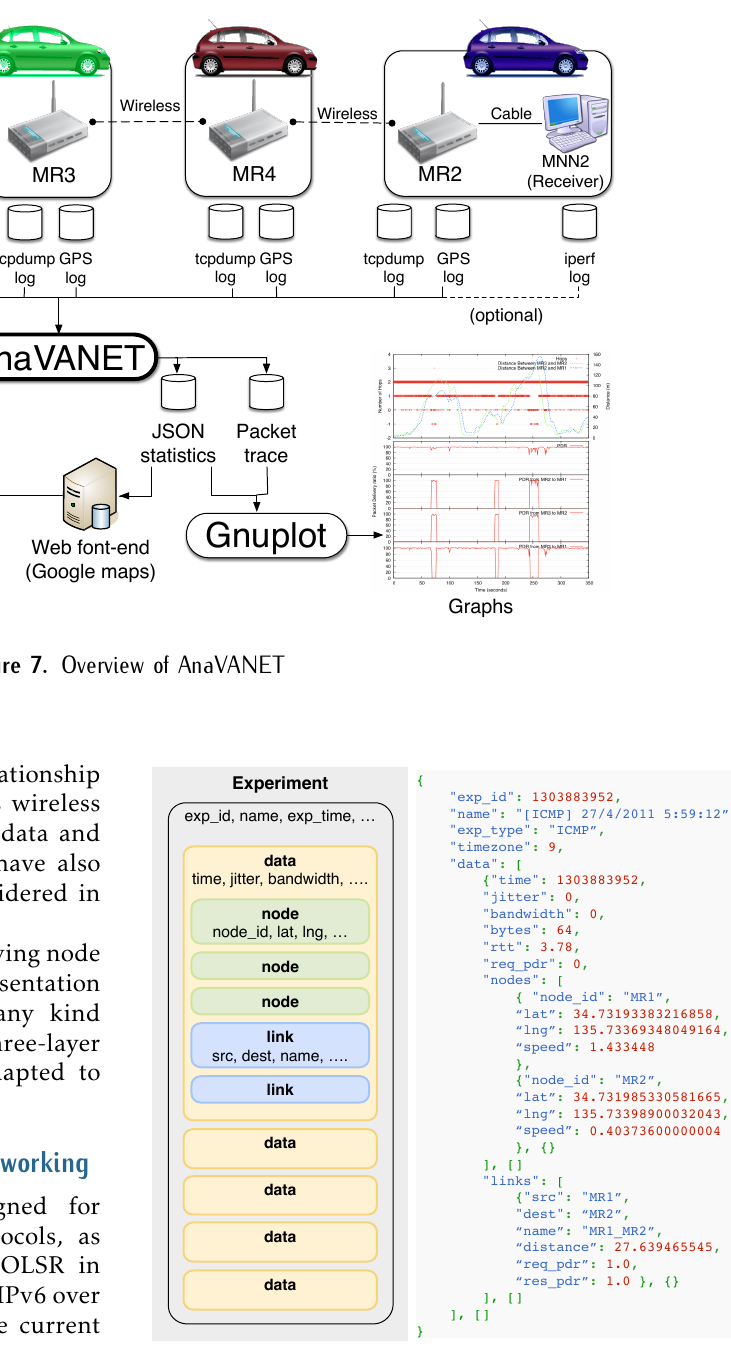
Figure 8. Three-layer model of the structured data format used by